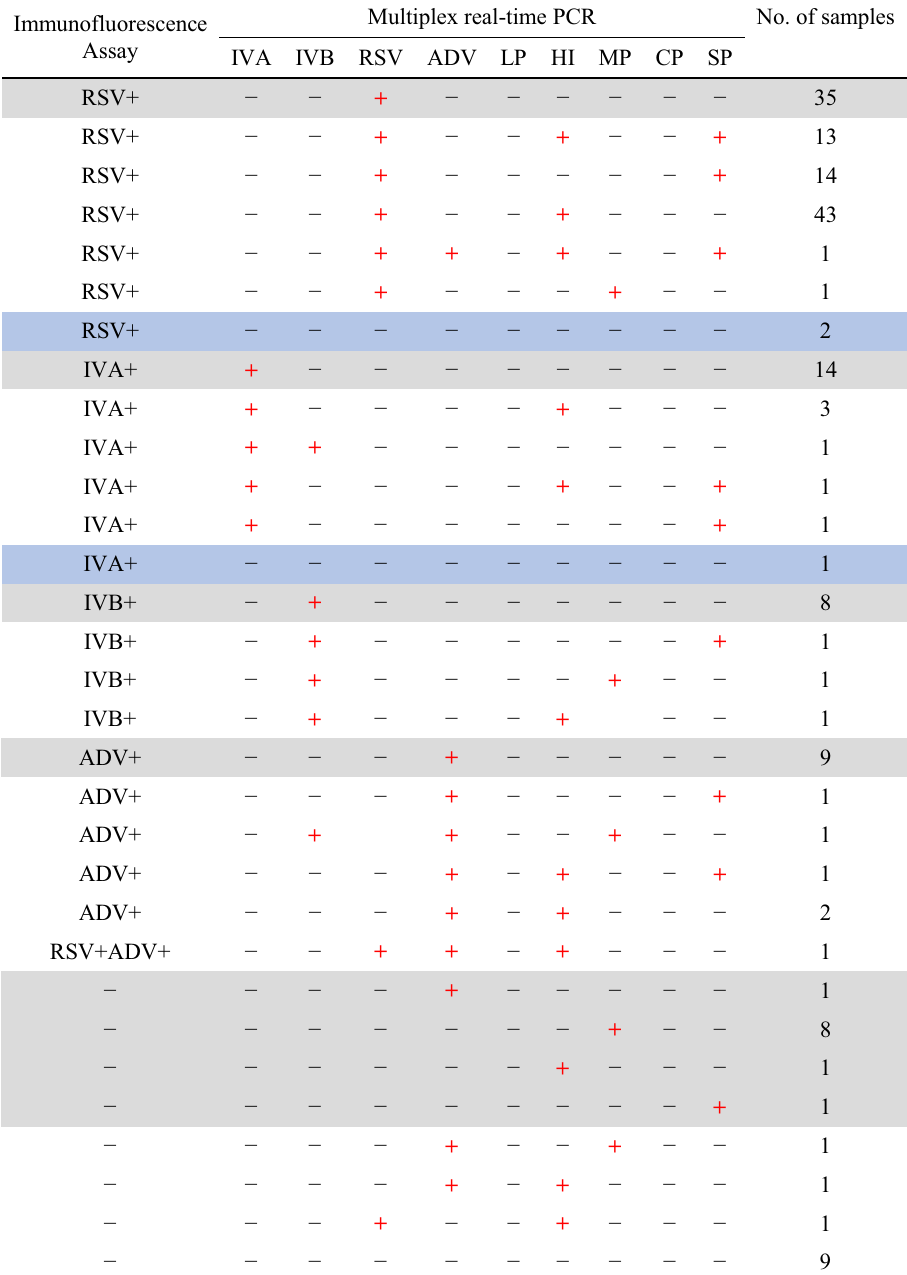
Table 3. Comparison of multiplex real-time RT-PCR and immunofluorescence assays for detecting 179 clinical specimens. +, positive; −, negative. LP: Legionella pneumophila , HI: Haemophilus influenzae , MP: Mycoplasma pneumoniae , CP: Chlamydia pneumoniae , SP: Streptococcus pneumoniae . Grey fill: Single infection confirmed by multiplex real-time RT-PCR; Blue fill: Immunofluorescence Assay reported positive but negative by multiplex real-time